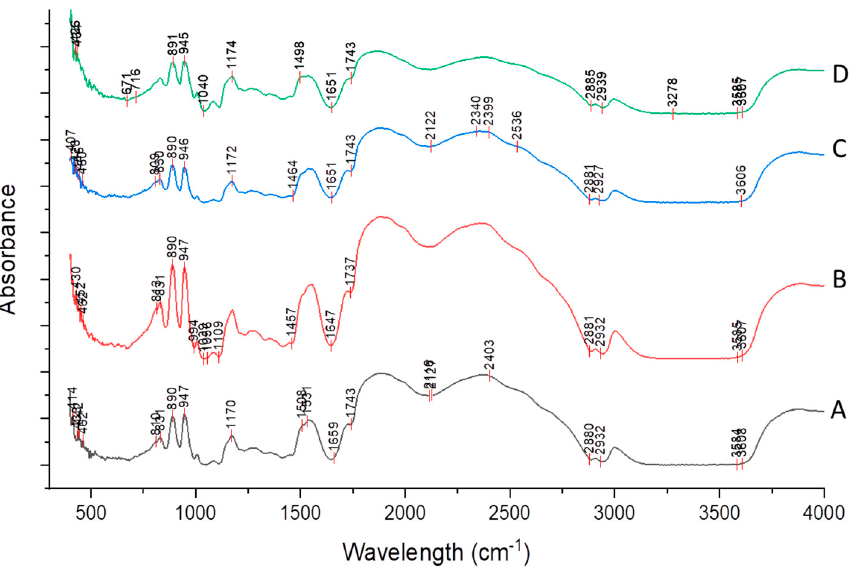
Figure 4. FTIR spectroscopy for sweet lime peel residue-based film added with 0% EO (Film A ), 1% EO (Film B ), 2% EO (Film C ) and 3% EO (Film D ).